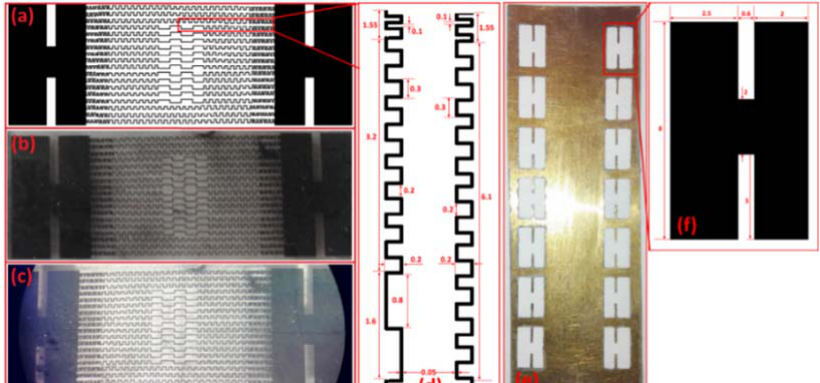
Figure 3. The deposited micro-heaters using mask #3: (a) The design of microheater and meanders; (b) Optical image of a real micro-heater element deposited onto glass substrate taken using the digital camera; (c) Optical image of the same micro-heater taken through the optical microscope; (d) The geometrical parameters of the heating elements (the units are presented in mm); (e) The optical image of the mask used for deposition of contacts for heating elements elaborated from the thin copper foil; (f) Geometrical parameters of the used contact for heating element.